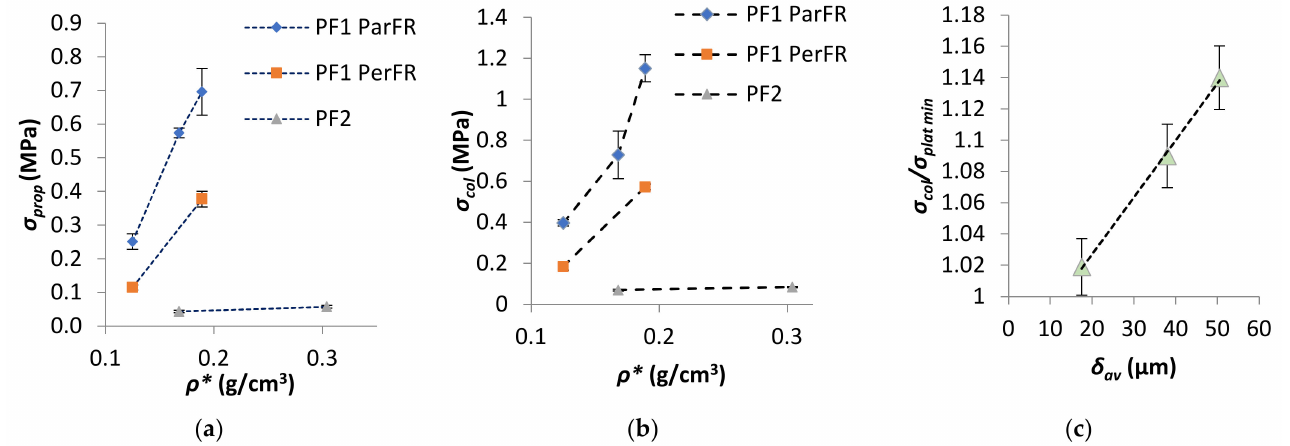
Figure 8. ( a ) σ prop as a function of ρ * for PF1, ( b ) σ col as a function of ρ * , and ( c ) ratio of σ col / σ plat min as a function of δ av for PF1